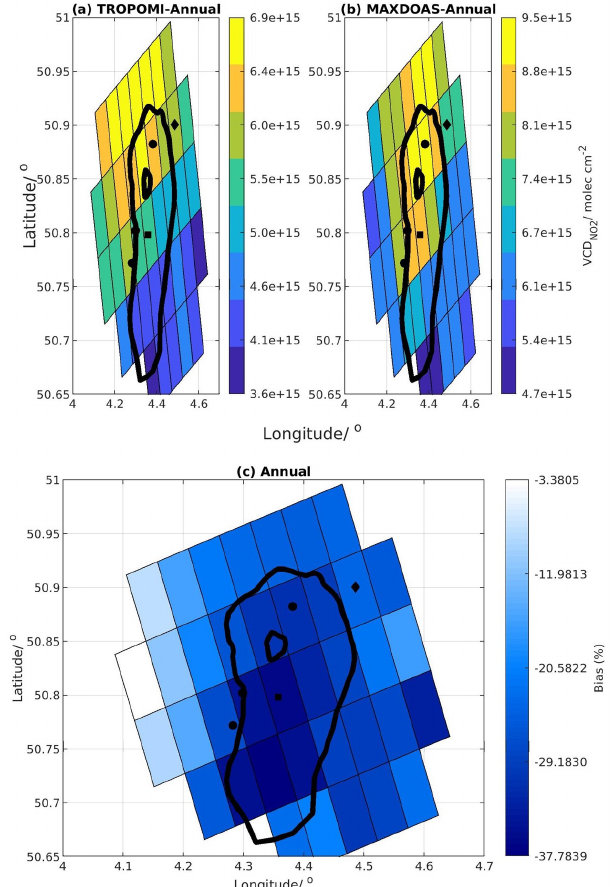
Figure 22. Annual (e.g., based over the 2 years of observations) tropospheric NO 2 VCD grids (TROPOMI grids) as retrieved over Brussels by (a) TROPOMI and (b) MAX-DOAS. (c) Annual bias between tropospheric NO 2 VCD as observed by TROPOMI and MAX-DOAS (the negative values are shown with blue, zero with white, and positive with red). The black square shows the MAX-DOAS instrument location, the black polygon the national airport, the black dots the NO 2 hotspots, and the black line the Brussels Ring road.